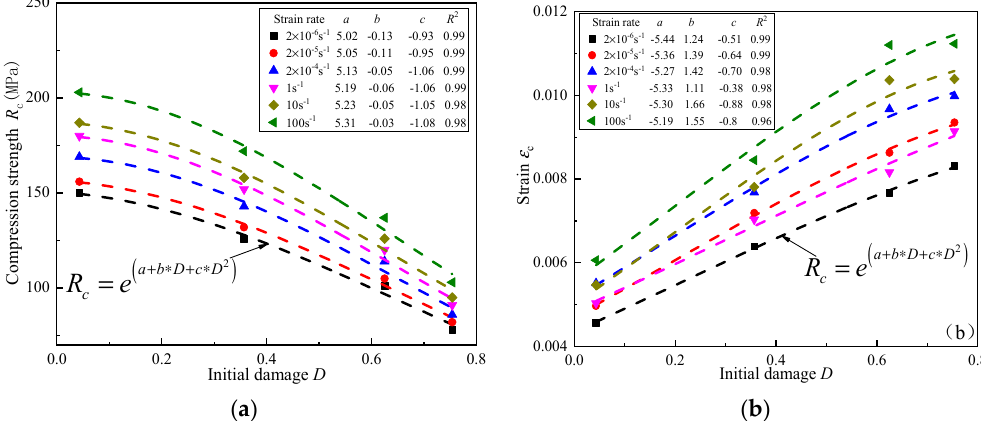
Figure 9. Plot of the compressive strength and yield strain versus initial damage for the axial tests from 2 × 10 − 6 s − 1 to 100 s − 1 levels of strain rate. ( a ) R c- D ; ( b ) ε c - D .